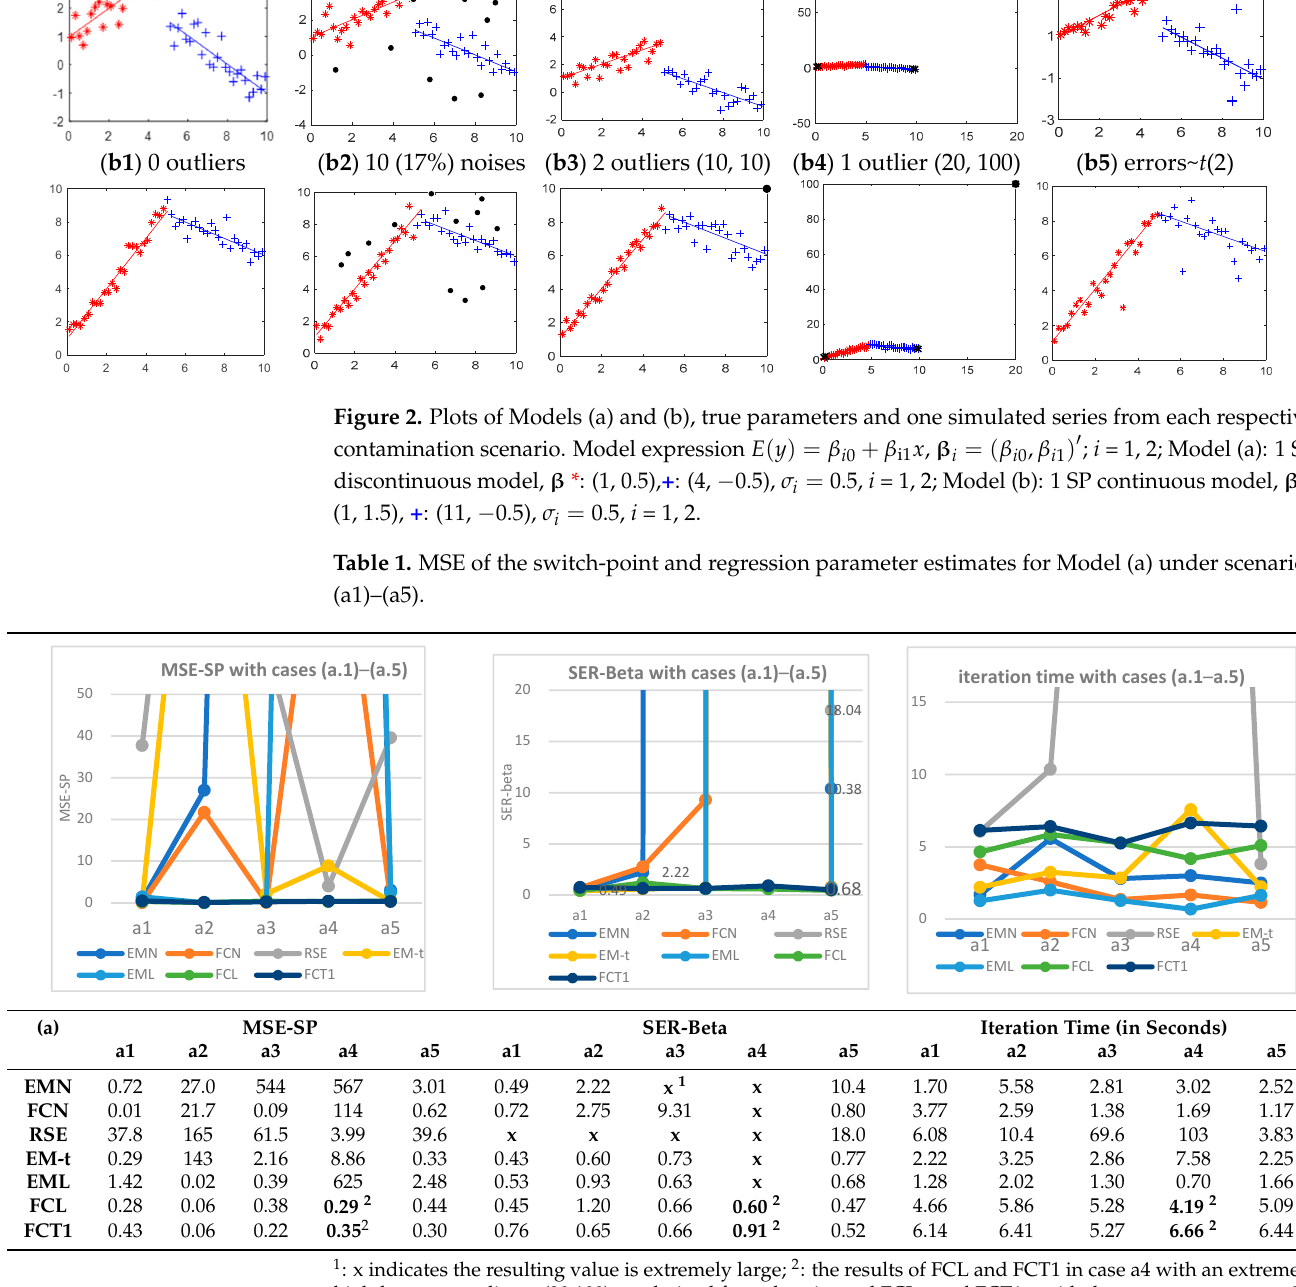
points, (4) extremely high leverage points, (5) errors having a heavy-tailed distribution. Tables 1 and 2 report the estimation results of Models (a) and (b), respectively, with both the numerical and graphical presentations.